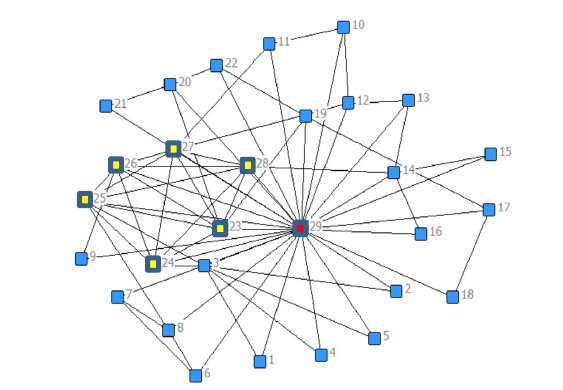
Figure 1. The network surrounding @yoko915